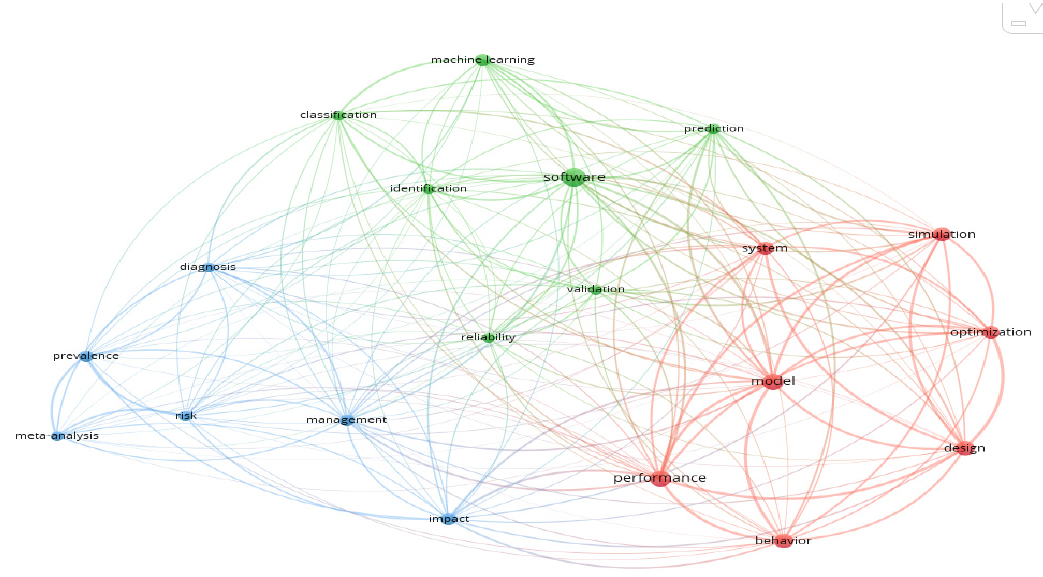
Figure 14. Word Cloud comprising top 50 most common words for the years 2019–2021.